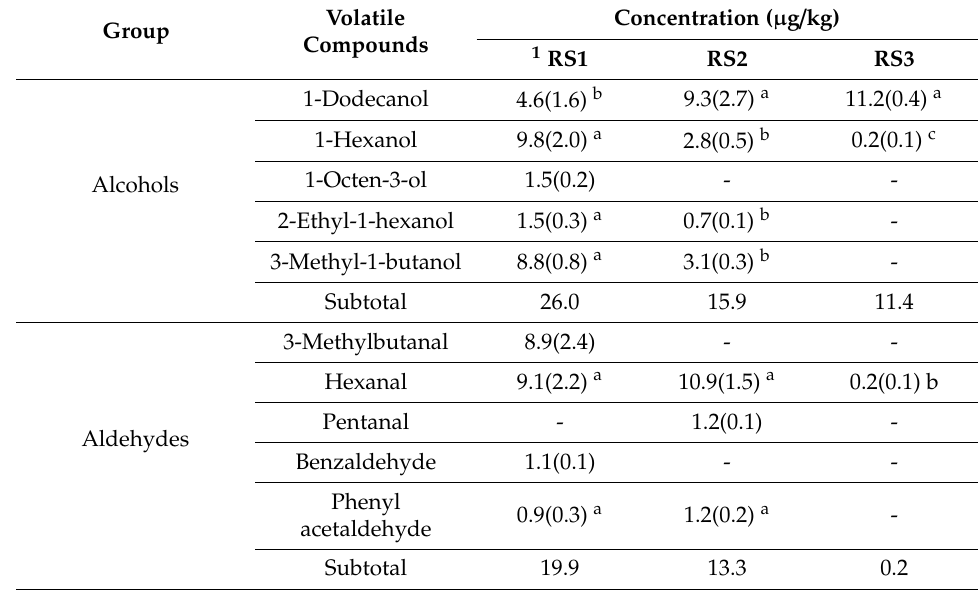
Table 2. Volatile aroma compound profiles of Shine Muscat grape berries at di ff erent ripening